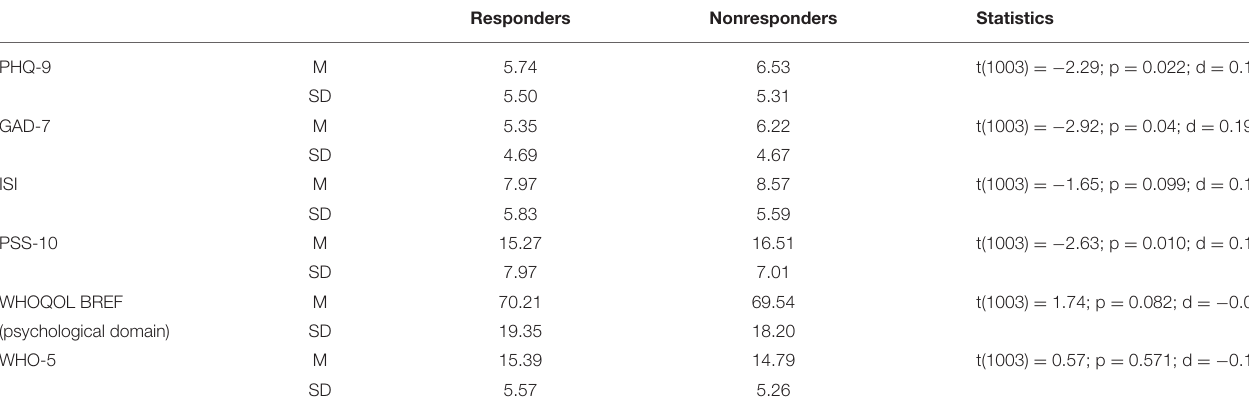
TABLE 3 | Measures of psychological health, well-being, perceived stress, depression, anxiety, and insomnia during the lockdown (t1) in responders ( n = 437) compared to non-responders ( n = 568). Responders